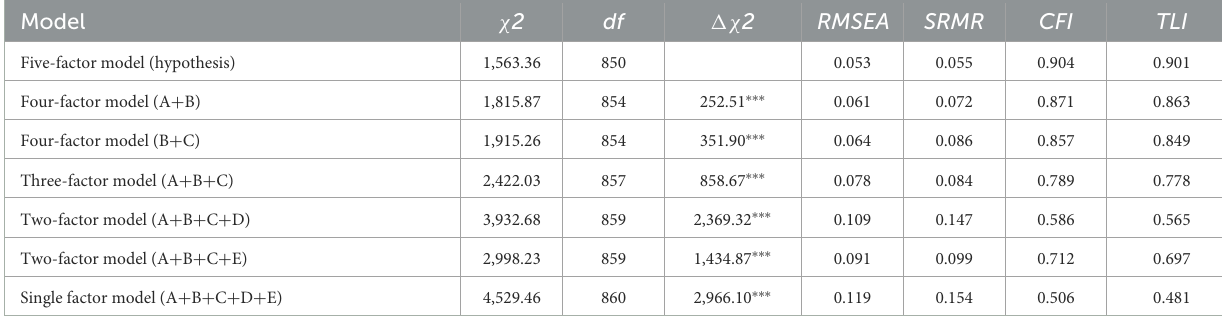
TABLE 2 Results of confirmatory factor analysis ( n = 300).